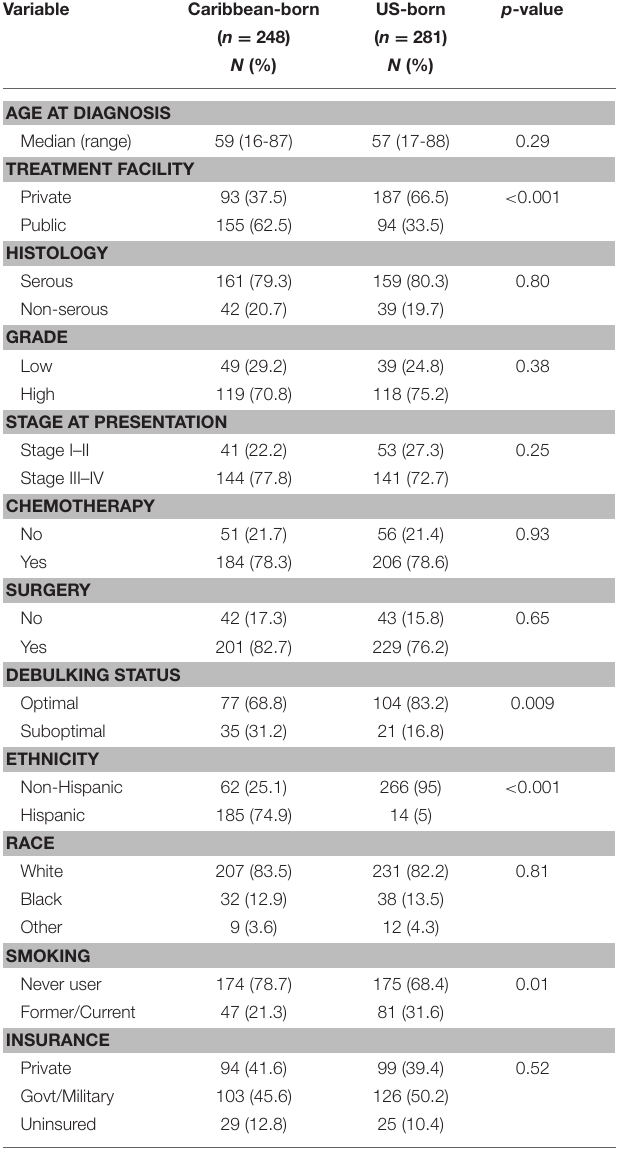
TABLE 1 | Cohort demographics by nativity. Variable